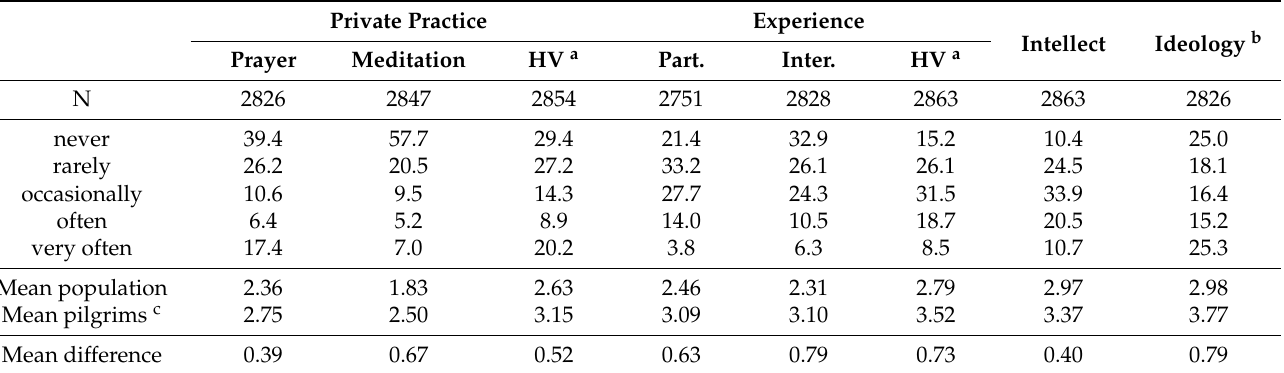
Table 5. Percentage distribution of responses and mean values of the six indicators on the four core dimensions of private practice, experience, intellect, and ideology in the normal population in Germany, Austria and Switzerland (weighted